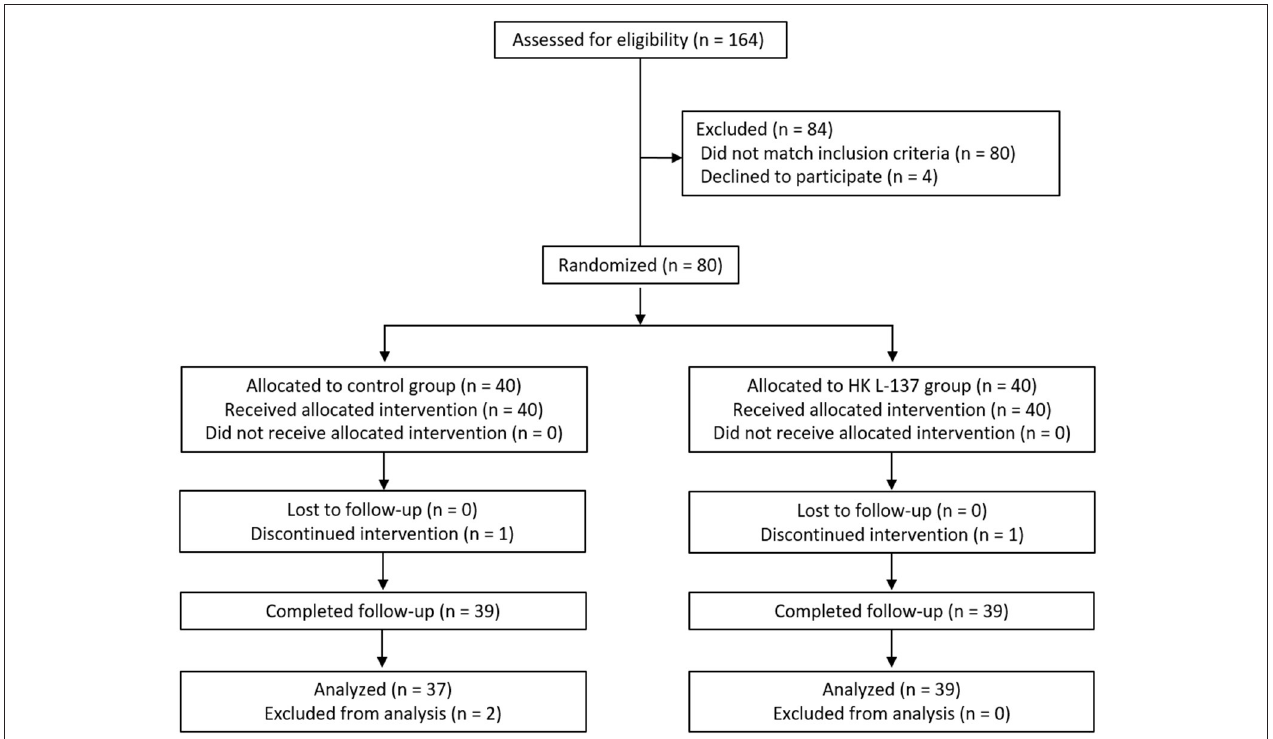
FIGURE 1 | Study flow diagram (CONSORT